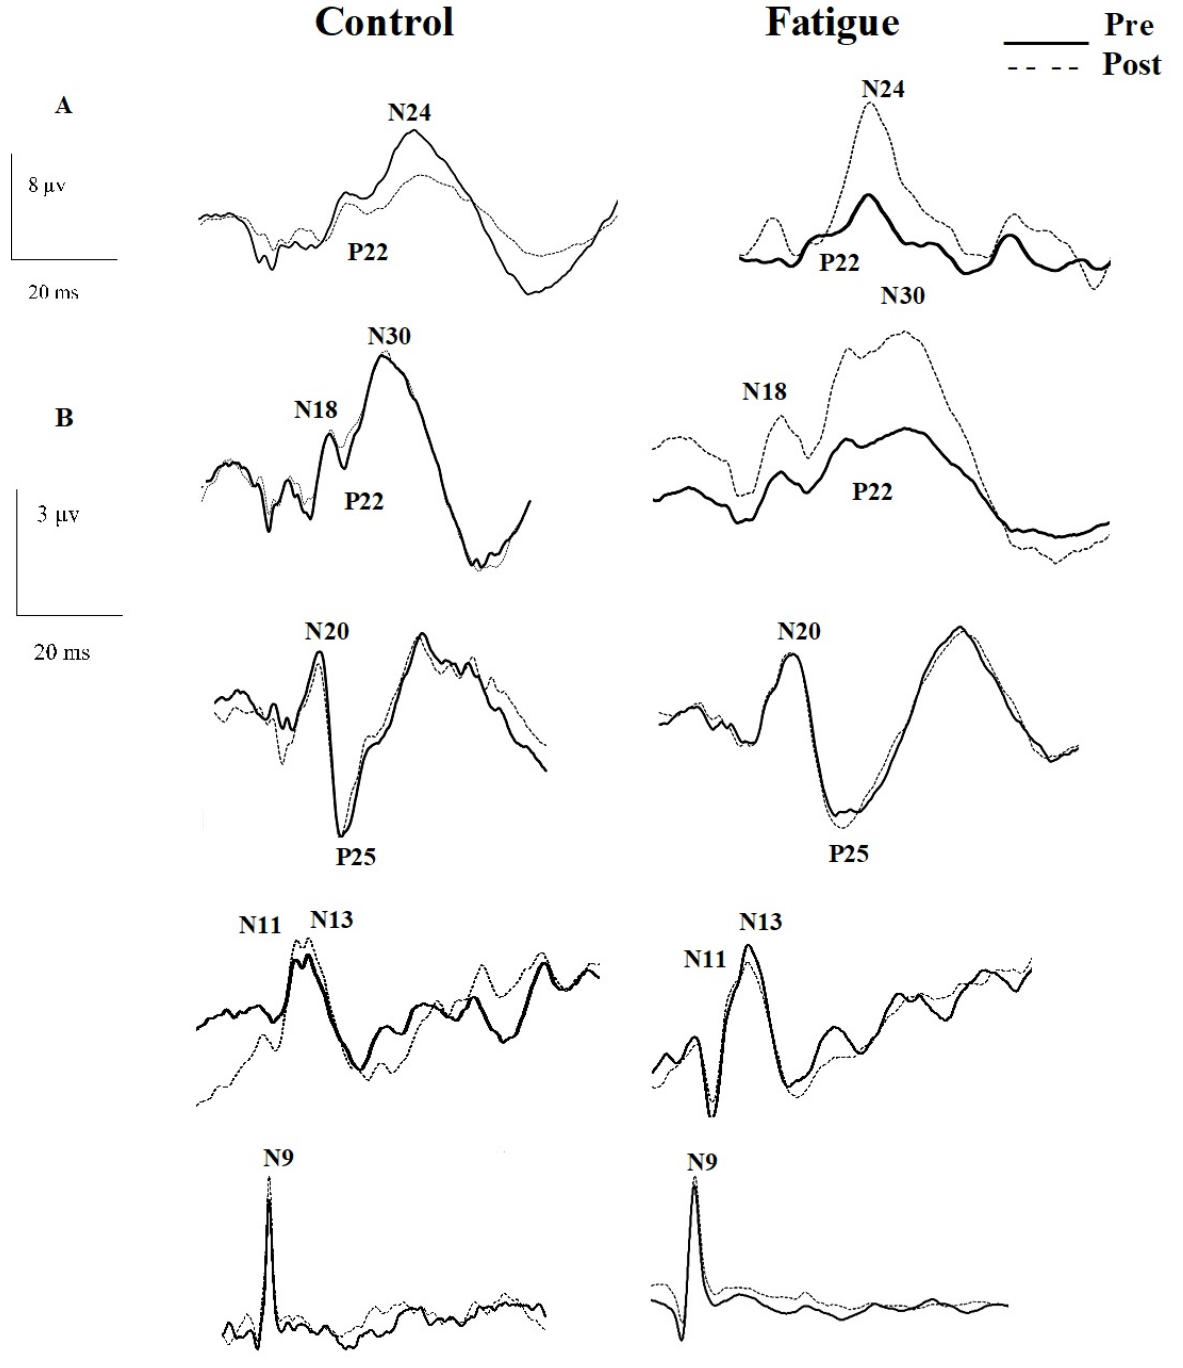
Figure 9. Raw data from a representative control and fatigue participant indicating cortical SEP peak amplitudes. ( A ) Fast rate (2.47 Hz), ( B ) Slow rate (4.98 Hz).